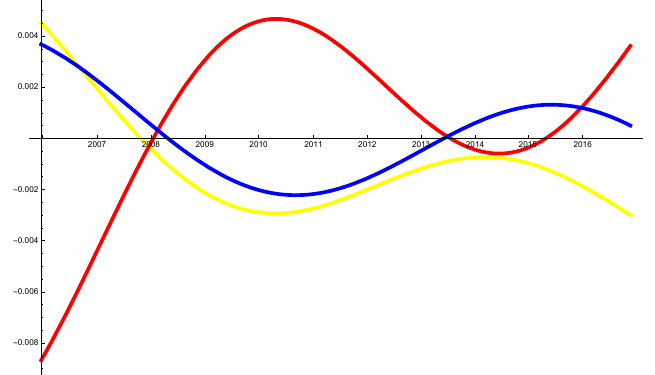
Figure 6. The x -axis represents time. The y -axis represents the value of the interaction coefficients of SOLAR (yellow), WIND (blue), and TECH (red) between 2006 and 2016.